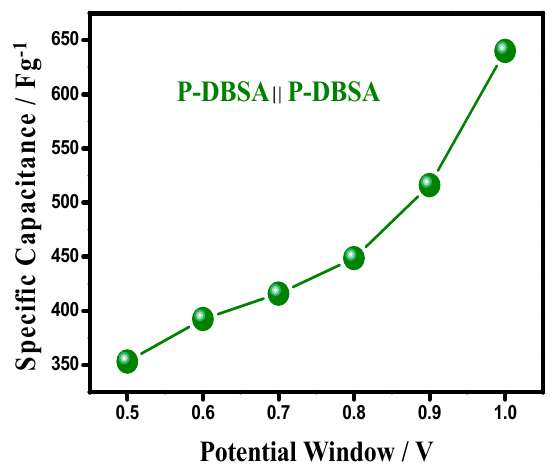
Figure 11. Increase in the upper potential resulting in the enhancement of a specific capacitance.